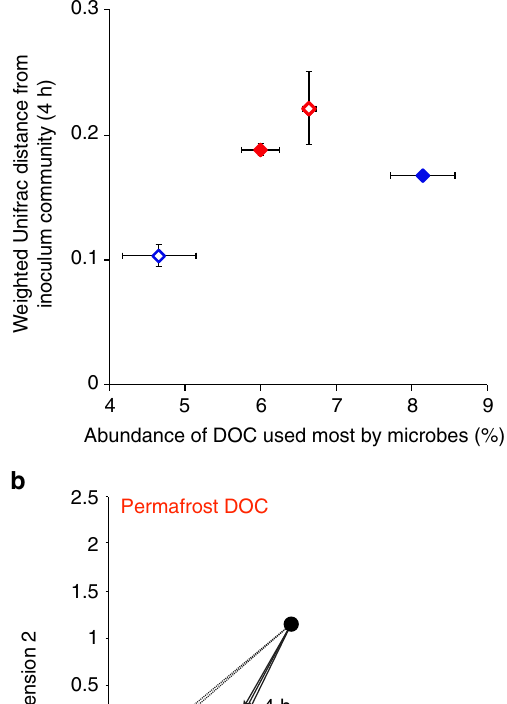
Fig. 3 Microbial community response to photo-altered dissolved organic carbon. a The magnitude of community shift from inoculum to the 4-h time points (weighted Unifrac distance) plotted against the abundance of dissolved organic carbon (DOC) most used by microbes native to each soil layer. DOC most used by microbes was de fi ned following the results in Fig. 1 and Supplementary Table 1: permafrost = aliphatic-like, atomic oxygen to carbon ratio < 0.5, molecular weight < 500 Da; organic layer = aromatic- like, atomic oxygen to carbon ratio > 0.6, molecular weight > 500 Da. Error bars indicate ± 1 standard error of the mean and in some cases are smaller than the symbol ( N = 2 or 3). Non-metric multidimensional scaling diagrams showing the magnitude and direction of change in microbial community composition (16S rRNA gene amplicon sequences) among inocula and incubations for b permafrost soil leachate, and c organic layer soil leachate based on beta-diversity calculations (weighted Unifrac distances for a rare fi ed data set; 3800 sequences per sample). Note that in b , permafrost, the dark 4-h symbols are hidden behind the light, 7-day